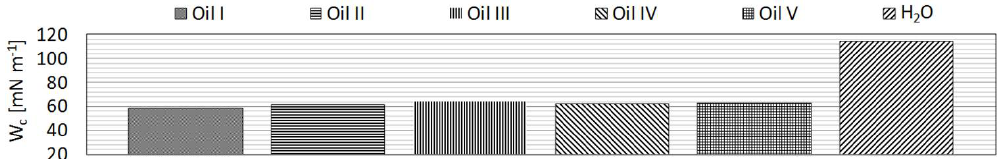
Figure 10. Calculated work of cohesion W c of the used functional